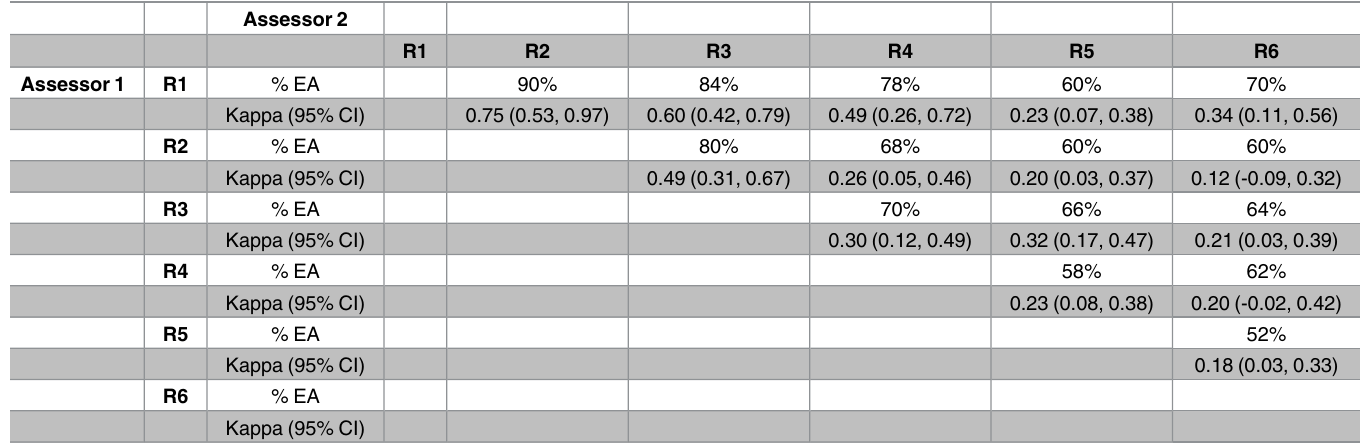
Table 1. Avoidability assessmentof ADR cases from phase 2.